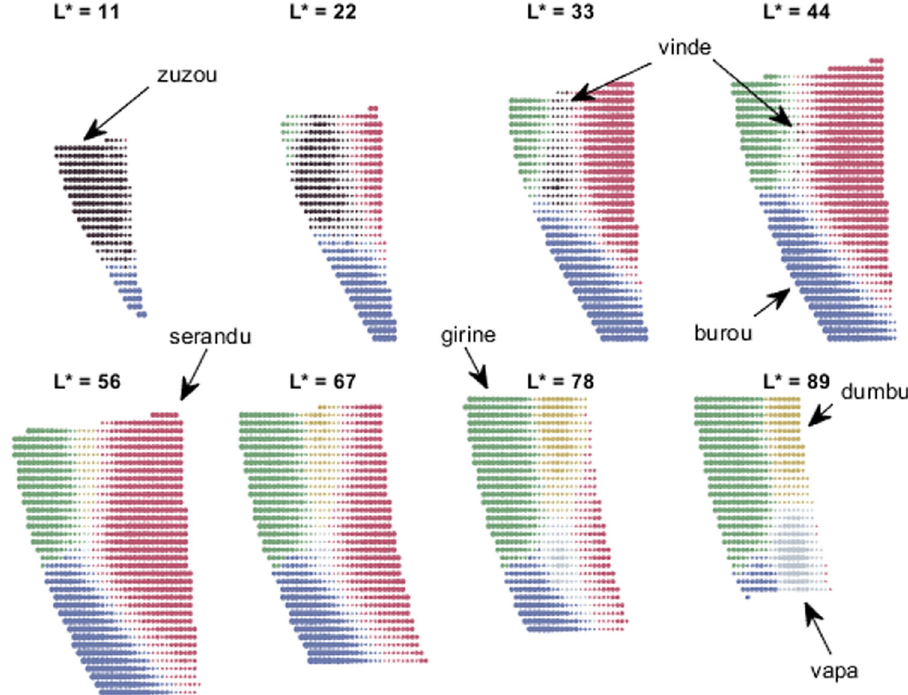
Fig. 4 Segmentation of CIELAB grid ( n = 5693) of 4-unit bins at 8 lightness levels into 7 Himba colour terms: serandu (red) 34.5%, grine (green) 23.2%, burou (blue) 22.9%, zoozu (black) 8.1%, dumbu (yellow) 7.7%, vapa (white) 3.5% and vinde (brown) 0.2%. The position of the newly identi fi ed term vinde is shown on two lightness levels. Disc size corresponds to the con fi dence of classi fi cation by the RST algorithm for the new data. The colour of each disc corresponds to the centroid of each identi fi ed colour